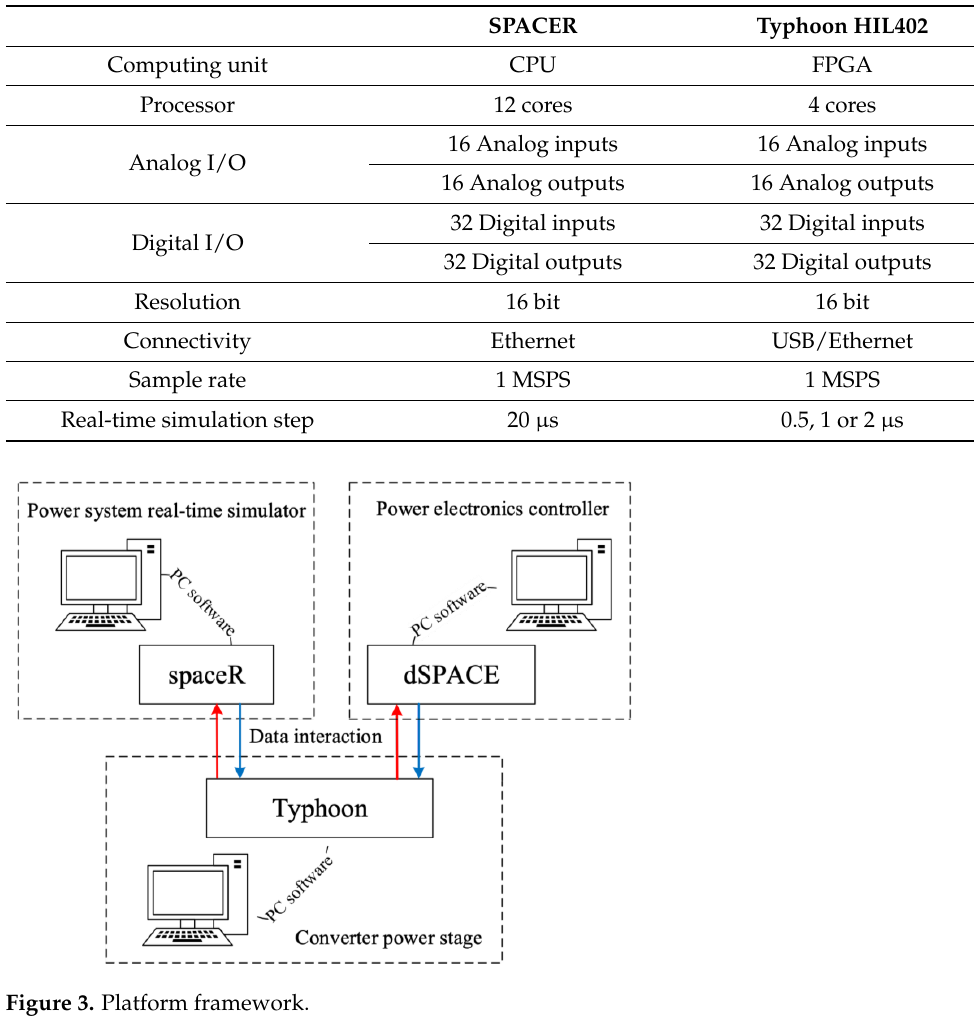
Figure 3. Platform framework.